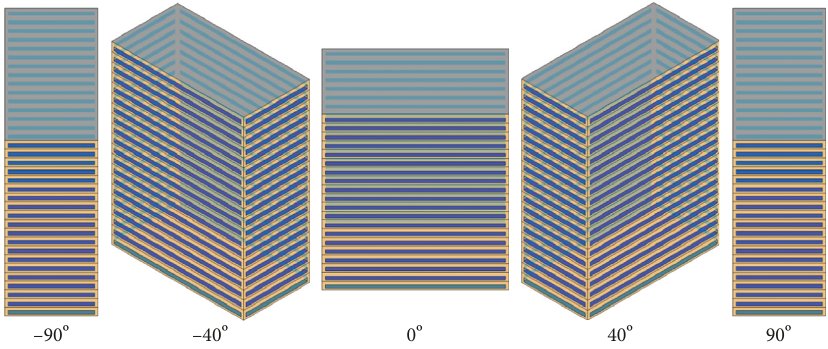
Figure 4: Energy model for analysis of direction using